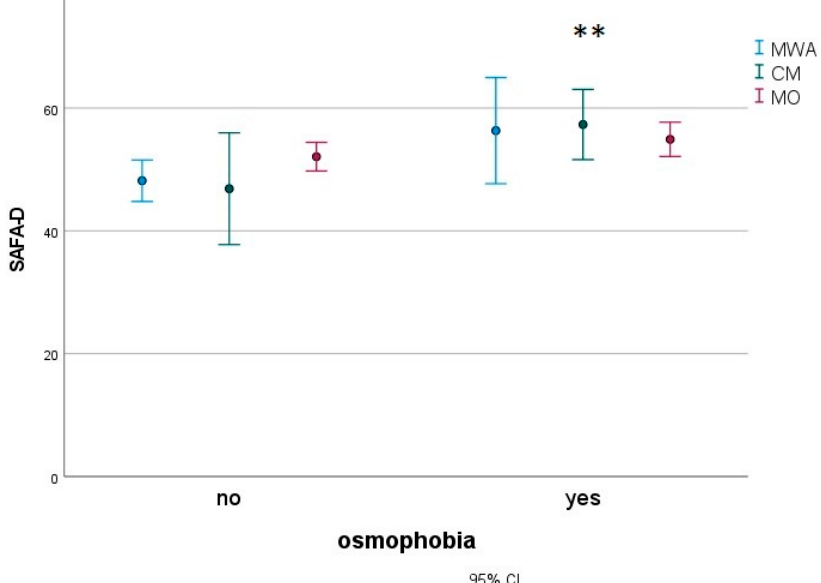
Figure 5. Mean and 95% C.I. of SAFA-Depression scores in osmophobic and non-osmophobic migraine children. MWA: migraine with aura; MO: migraine without aura; CM: chronic migraine. Results for osmophobia as a factor ** F 9.18, p = 0.003.